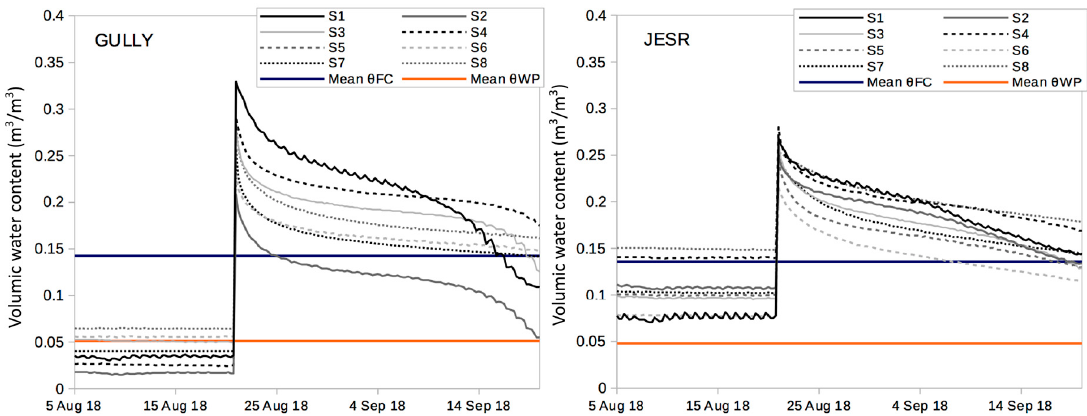
Figure 8. Evolution of soil moisture at different depths (eight sensors) in the gully and the Jesr after the thunderstorm on 19 August 2018.